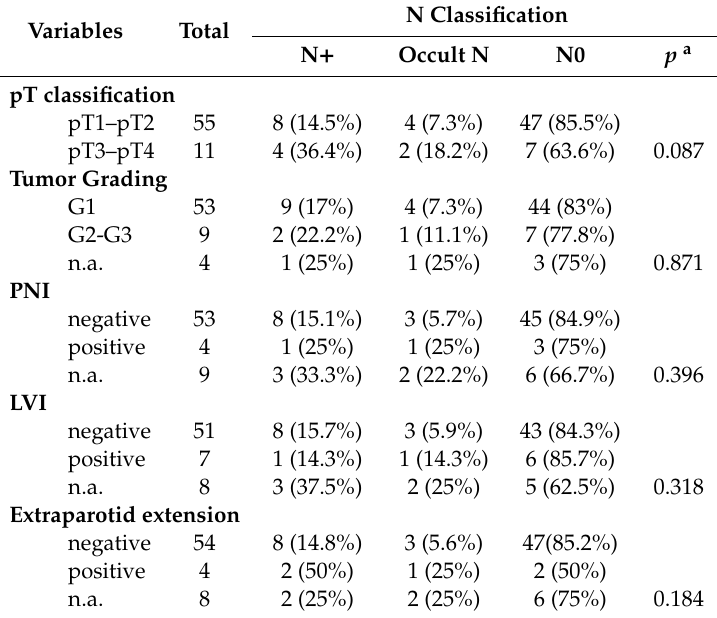
Table 2. Clinicopathological variables a ff ecting lymph nodes